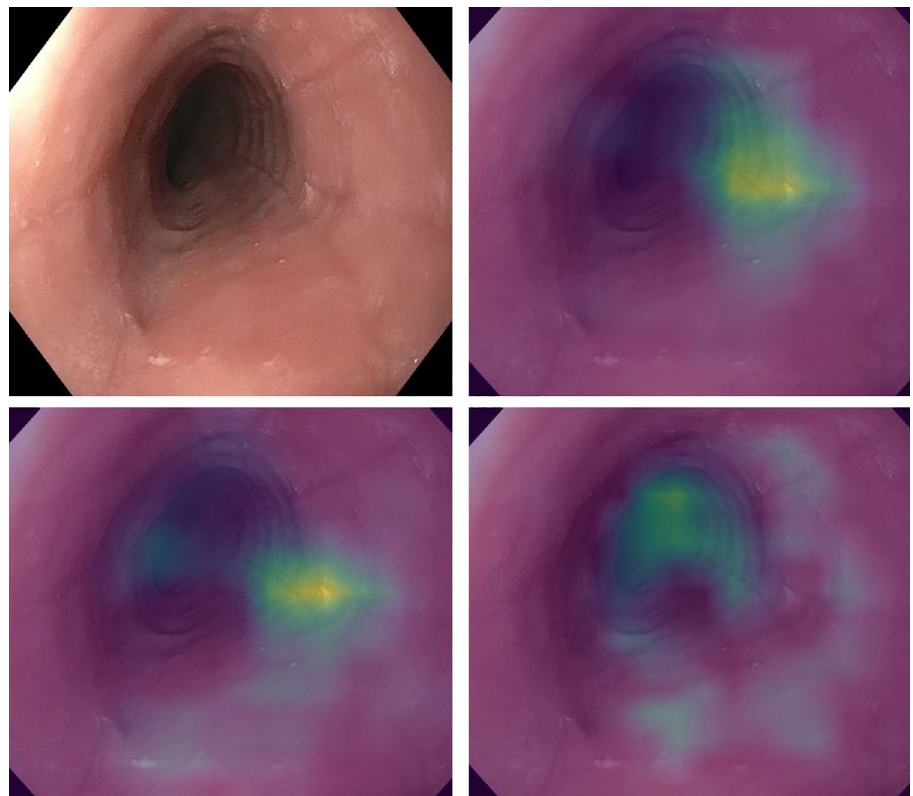
Figure 5. Features detected on input images by AI-EoE-EREFS are highlighted using Gradient-based visualization (Grad-CAM) 28 : the top left image shows the original endoscopic image with furrows, exudates, and rings; in the top right image, furrows are highlighted, while in the bottom left and bottom right images, exudates, and rings are highlighted,